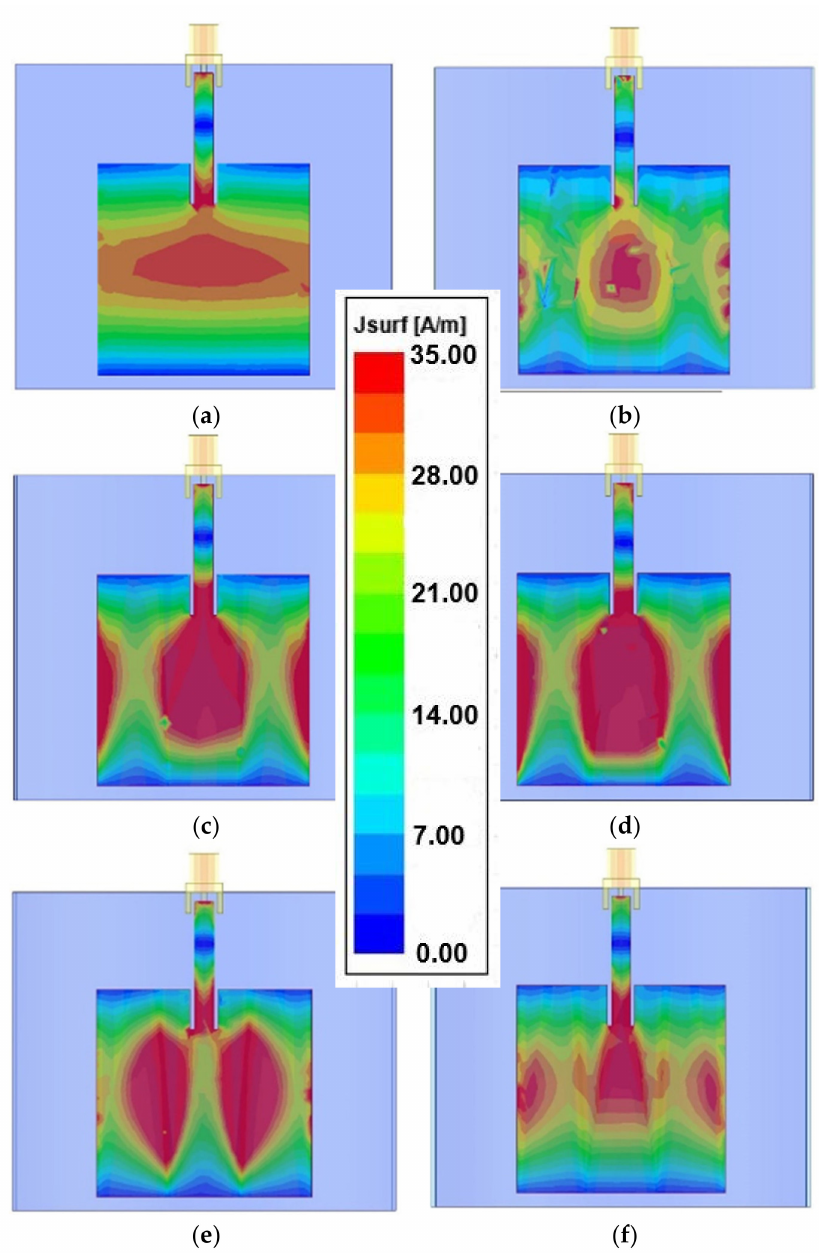
Figure 14. Full-wave simulated current distribution plot of the 3D-printed Electrifi antenna prototype at 2.4 GHz on ( a ) flat surface; ( b ) cylindrical surface of radius 88 mm; ( c ) cylindrical surface of radius 75 mm; ( d ) cylindrical surface of radius 60 mm; ( e ) cylindrical surface of radius 50 mm; and ( f ) cylindrical surface of radius 43